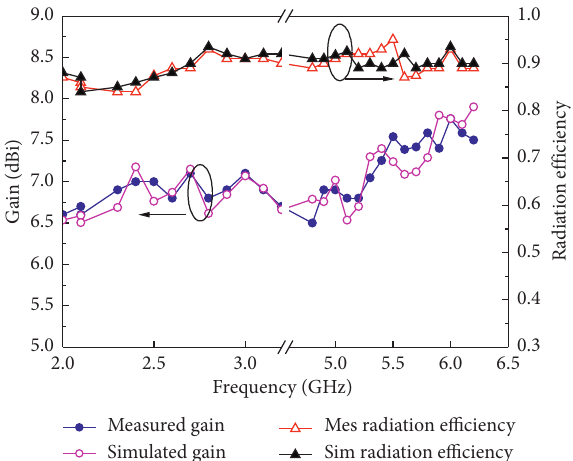
Figure 14: Measured and simulated gain and radiation efficiency for the proposed